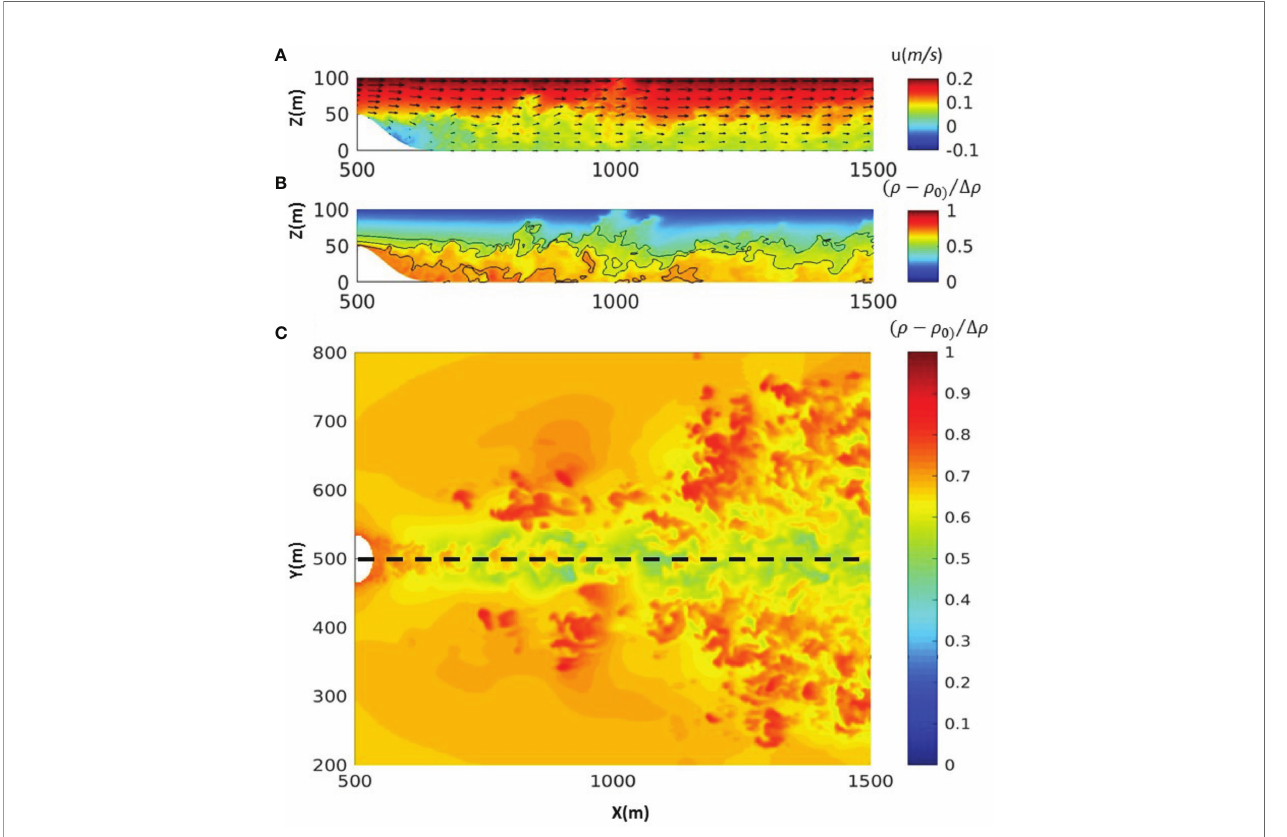
FIGURE 5 | Model simulations ( Fr =0.25) of (A) streamwise velocity at the central transect of the spanwise direction, (B) normalized density ( r – r 0 )/ Dr , where Dr is the density difference between the top and bottom boundary and r 0 is the background density, and (C) the plane view of normalized density at z = 50m. The yellow dashed line indicates the central transect in the spanwise direction. The three-dimensional topography is parameterized by a Gaussian